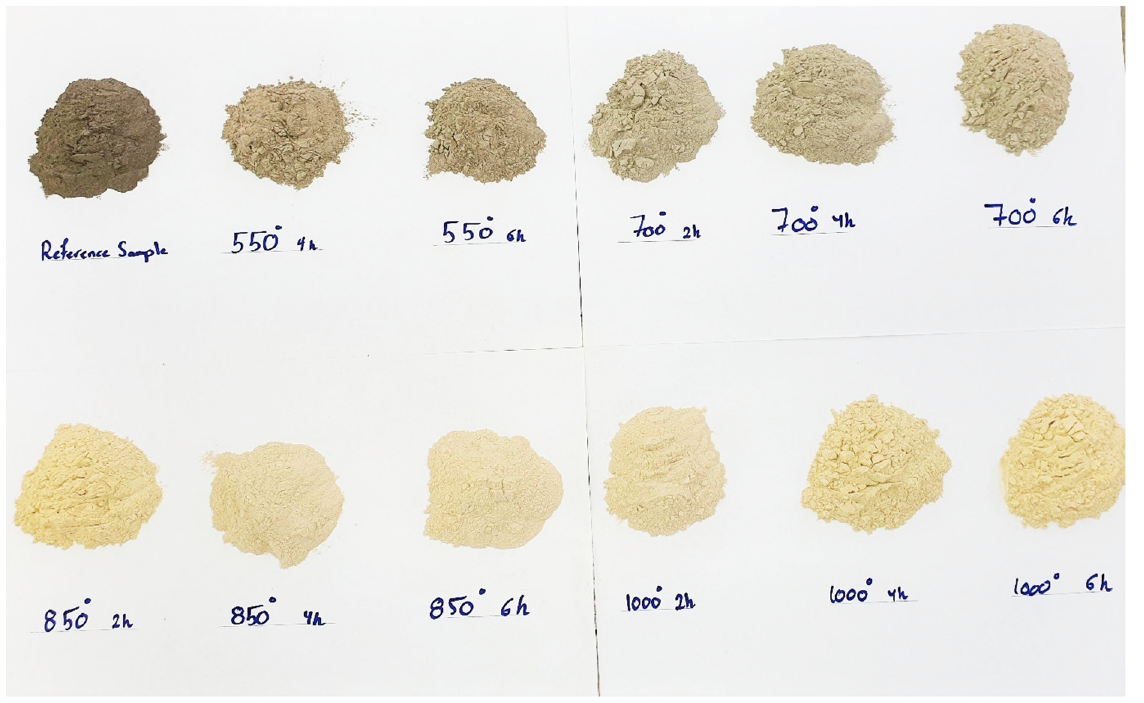
Figure 1. Difference in color of raw and treated FOSA at selected calcination temperatures and du- rations. and